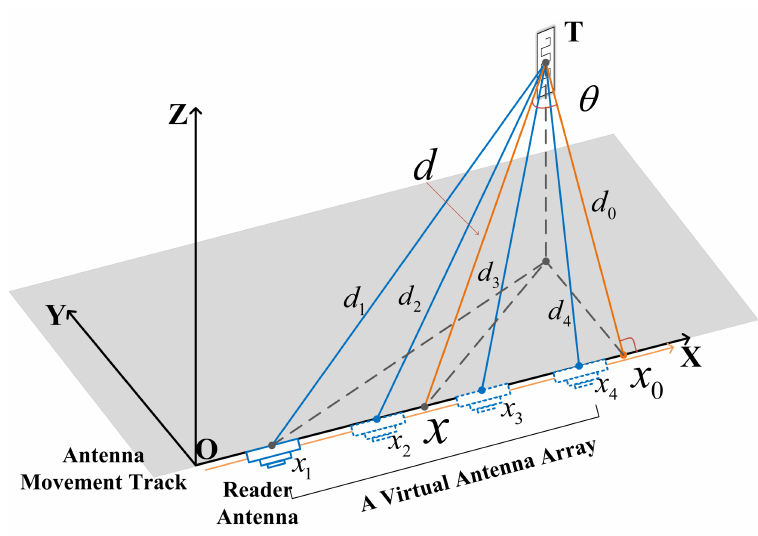
Figure 4. The direction of arrival of the tag with mobile